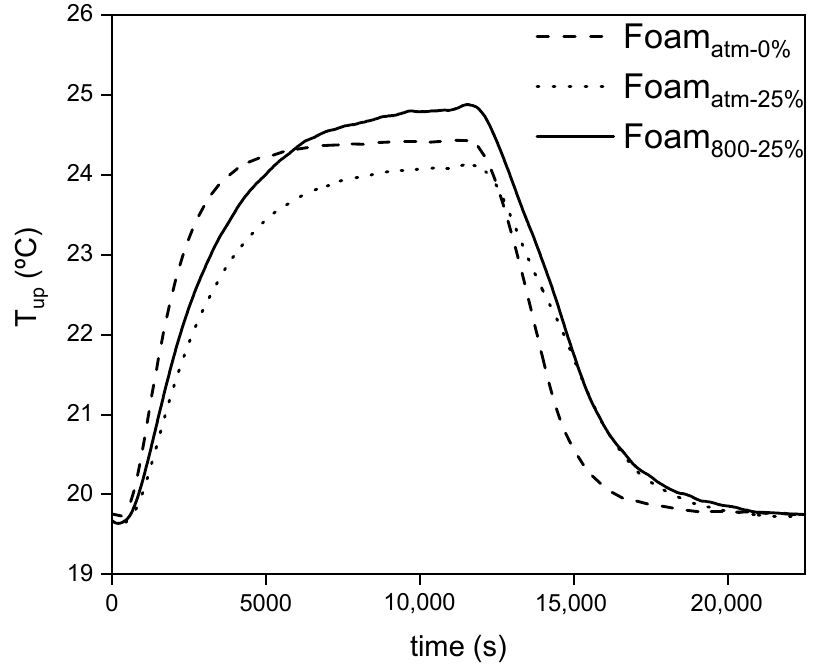
Figure 11. Temperature profiles of the external surface ( T up ) of the selected composites subjected to a heating-cooling cycle.